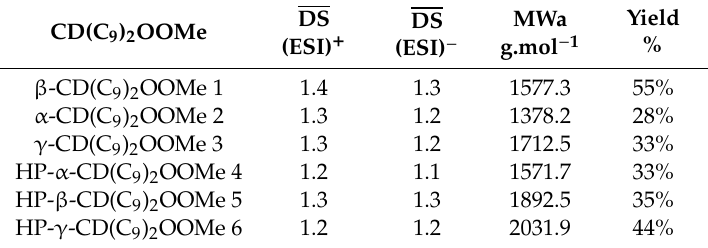
Table 1. CD(C 9 ) 2 OOMe derivatives 1 – 6 obtained by ball milling (the experimental conditions are depicted Scheme 2).